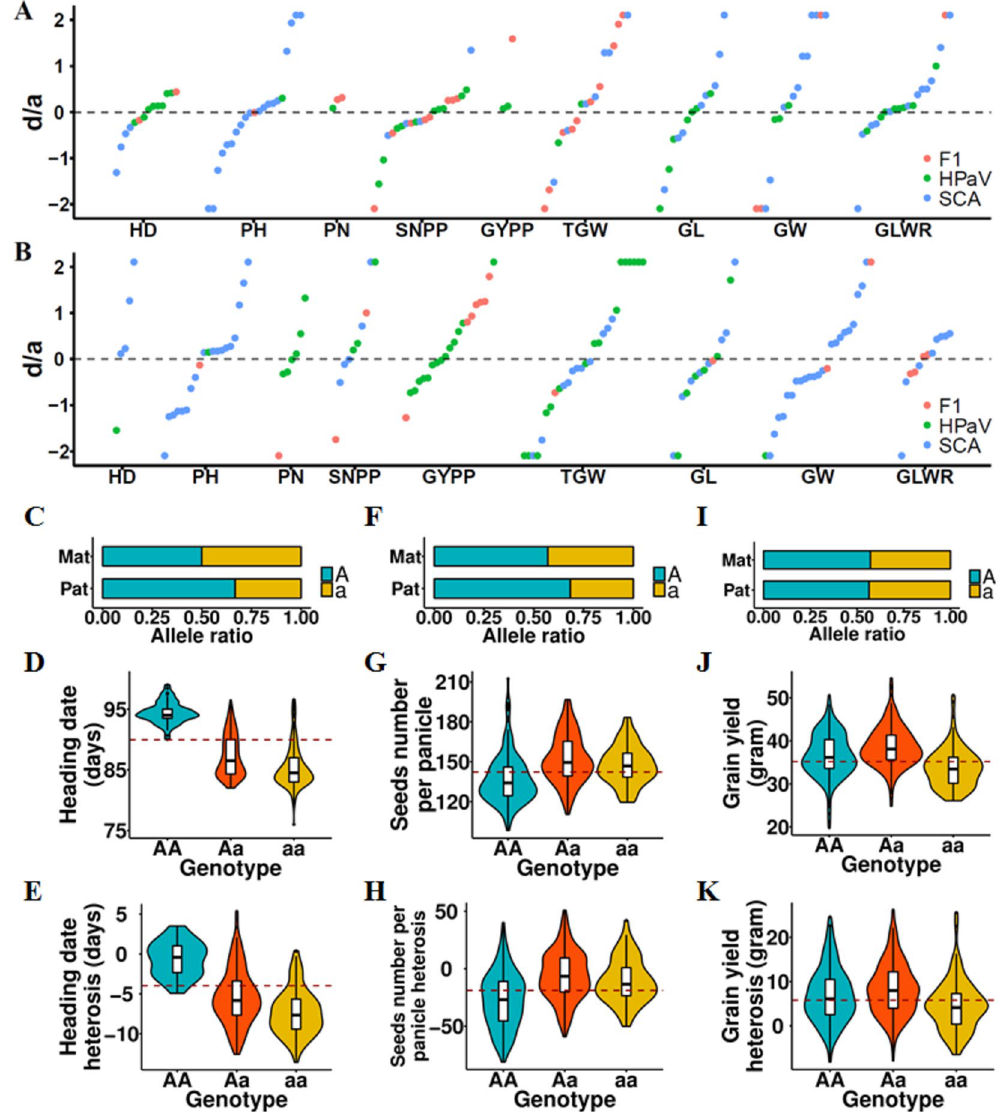
Figure 4. Non-additive effects played important roles in rice heterosis. ( A,B ) Dominance/additive (d/a) effects for all three-genotype QTLs identified in the CS ( A ) and LS ( B ) datasets. ( C ) Allele ratios of the QTL (lead SNP: F0921300849AC) in both parental groups (A: major allele; a: minor allele). ( D,E ) HD ( D ) and HD_BPaV ( E ) distributions for the QTL F0921300849AC. ( F ) Allele ratios of the QTL harboring OsmiR156h in both parental groups. ( G,H ) SNPP ( G ) and SNPP_BPaV (h) distributions for the QTL harboring OsmiR156h . (i) Allele ratios of the QTL harboring MSP1 in both parental groups. ( J,K ) GYPP (j) and GYPP_BPaV (k) distributions for the QTL harboring MSP1 . The red dashed lines in d, e, g, and h represent the mean values for the averages of the two